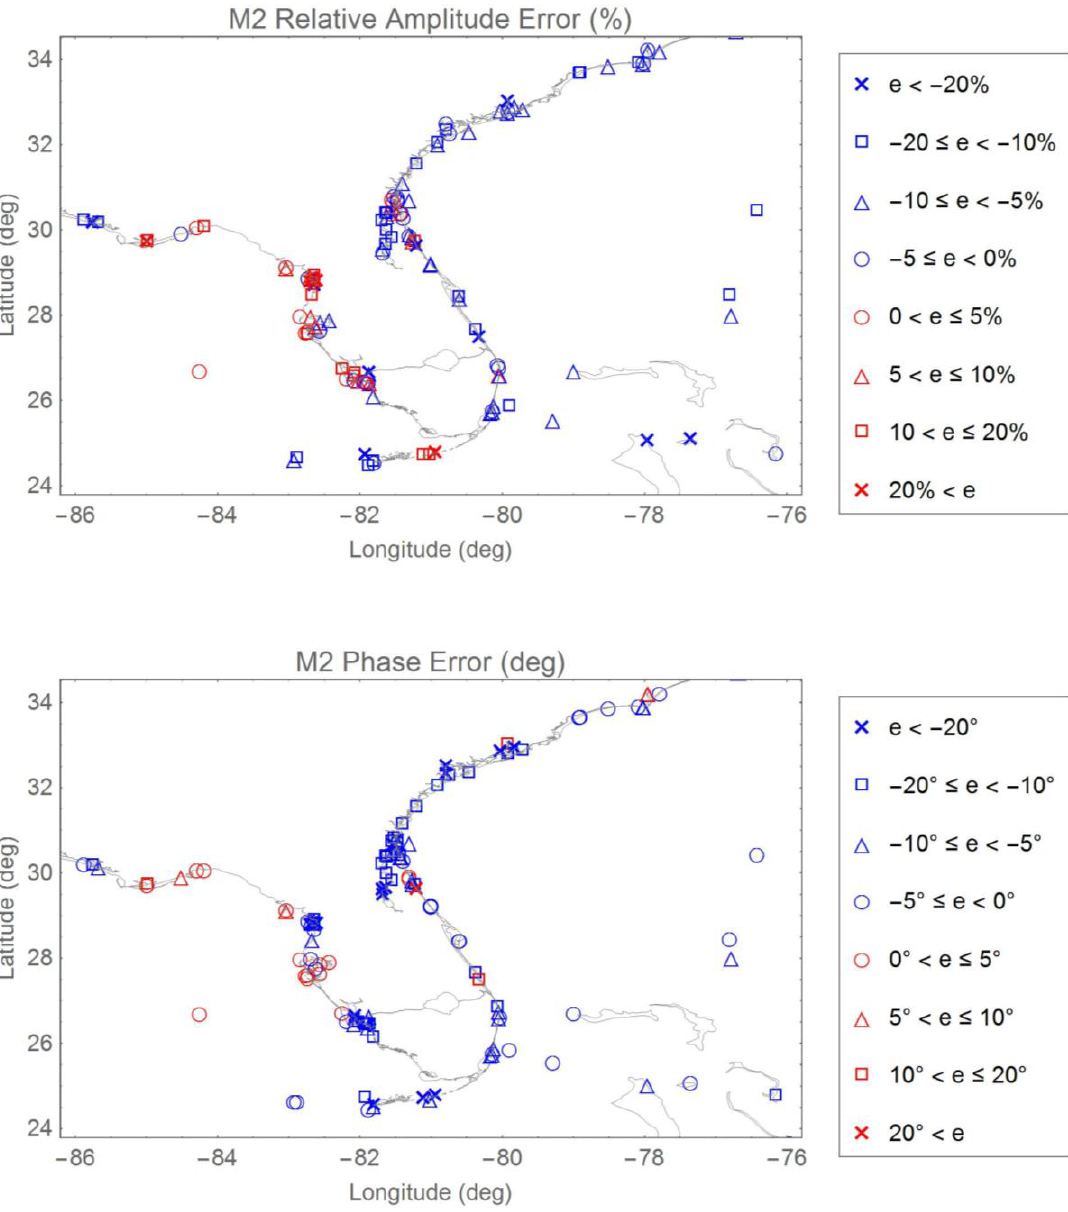
Figure C7. Distribution of relative amplitude and absolute phase errors for the M 2 constituent: Florida coast.